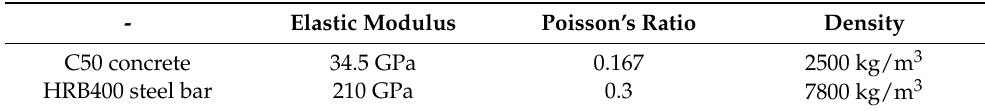
Table 1. Material parameters of the storage tanks.